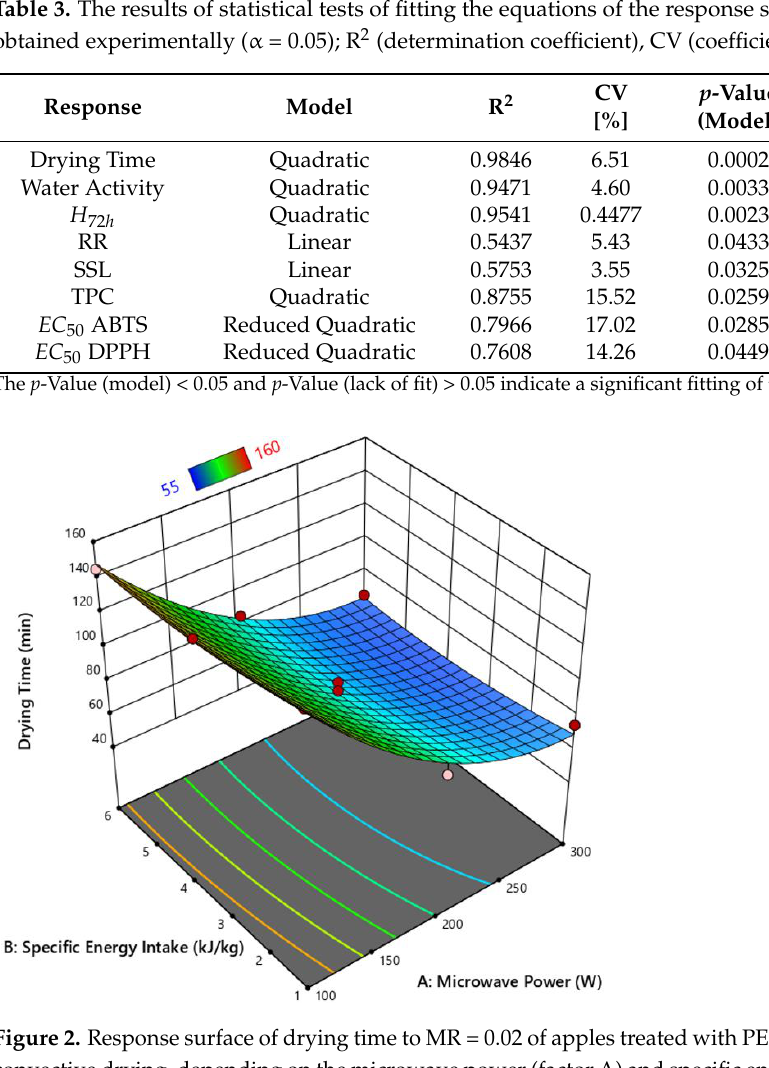
Figure 2. Response surface of drying time to MR = 0.02 of apples treated with PEF prior to microwave-convective drying, depending on the microwave power (factor A) and specific energy intake (factor B). Table 3. The results of statistical tests of fitting the equations of the response surfaces to the values obtained experimentally (α = 0.05); R 2 (determination coefficient), CV (coefficient of variation).